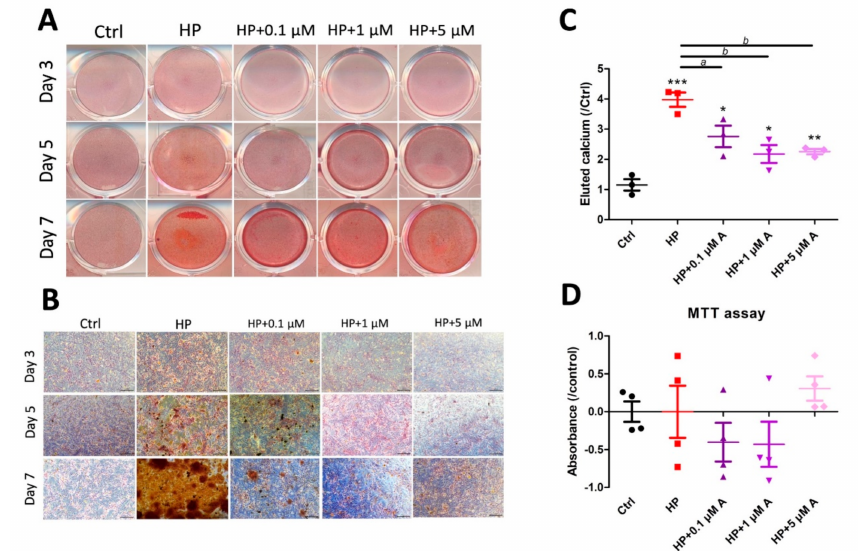
Figure 1. Selecting the optimal experimental condition for astaxanthin in VC models. ( A ) Macroscopic and ( B ) microscopic examination of vascular smooth muscle cells subjected to DMEM or HP media with di ff erent concentrations of astaxanthin over 3, 5, and 7 days. Scale bar, 200 µ m. ( C ) Quantitation